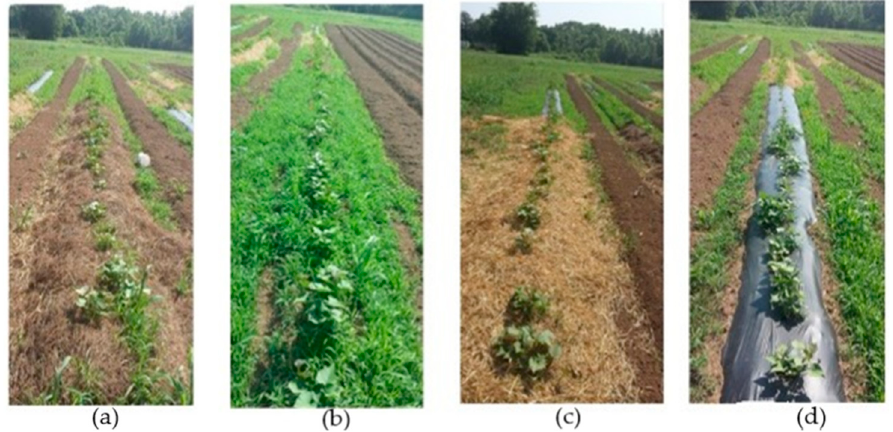
Figure 3. Mulch treatments in sweetpotato field. From left to right are: ( a ) pine needle (PN), ( b ) no mulch (NM) control plot, ( c ) wheat straw (WS), and ( d ) black plastic mulch (PL).